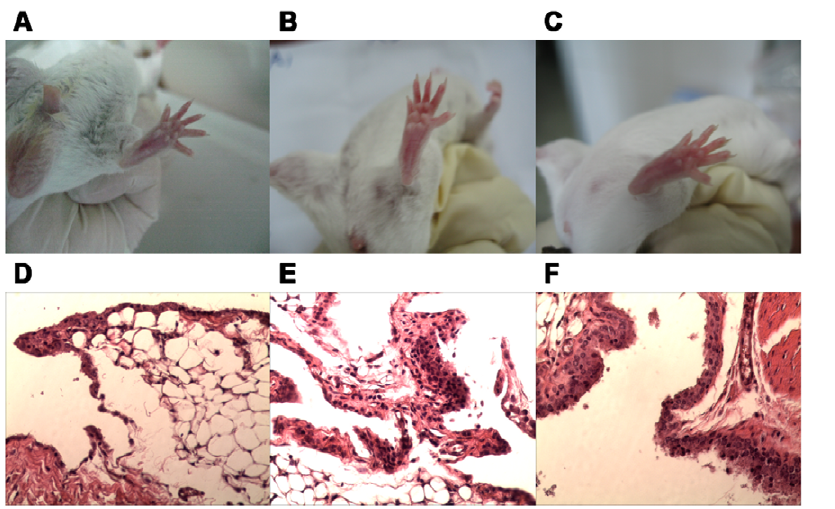
Figure 1. Morphological inflammation of erythematous and edematous paws and histochemical lesions of synovial hyperplasia and inflammatory infiltration in BIA and CIA mice. A and D. Control; B and E. BIA mice; C and F. CIA mice. HE staining of sections and microscopic analysis were carried out by sampling hind paws of mice after modeling for 28 d. The histochemical photographs were amplified for 100